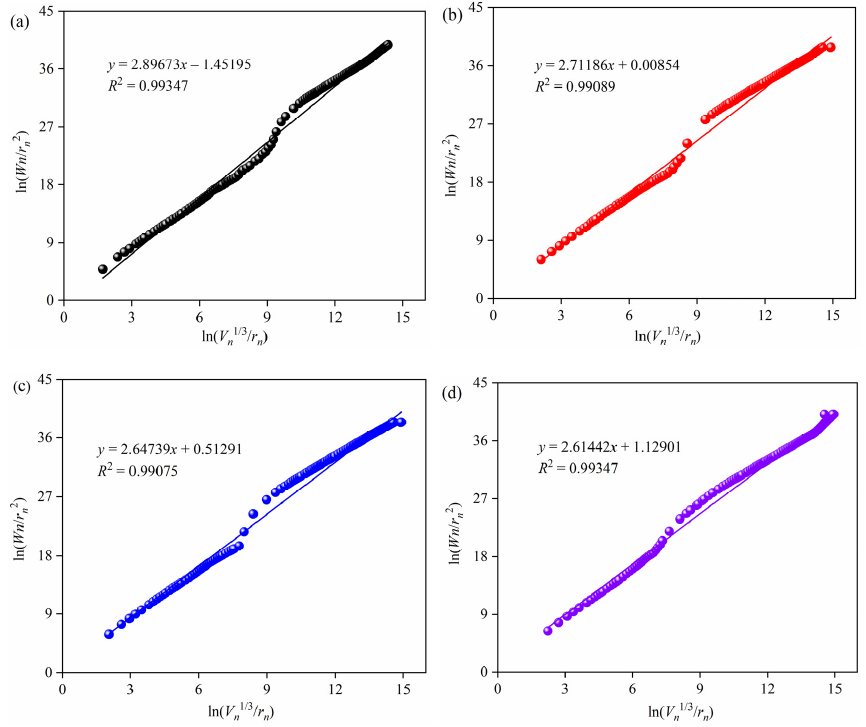
(cid:16) V 1/3 (cid:17) (cid:16) (cid:17) W n Figure 10. Logarithmic plots of n (cid:3289)(cid:3117)/(cid:3119) and for samples with different pore-forming agent r n (cid:3440) and (cid:4672) (cid:3024) (cid:3289) (cid:4673) for samples with different pore-forming agent r 2 n Figure 10. Logarithmic plots of (cid:3436) (cid:3023) (cid:3045) (cid:3289) (cid:3045) (cid:3289)(cid:3118) contents, i.e., ( a ) 20 vol.% pore-forming agents + 80 vol.% alumina; ( b ) 30 vol.% pore-forming agents + 70 vol.% alumina; ( c ) 40 vol.% pore-forming agents + 60 vol.% alumina; ( d ) 50 vol.% pore-forming agents + 50 vol.%